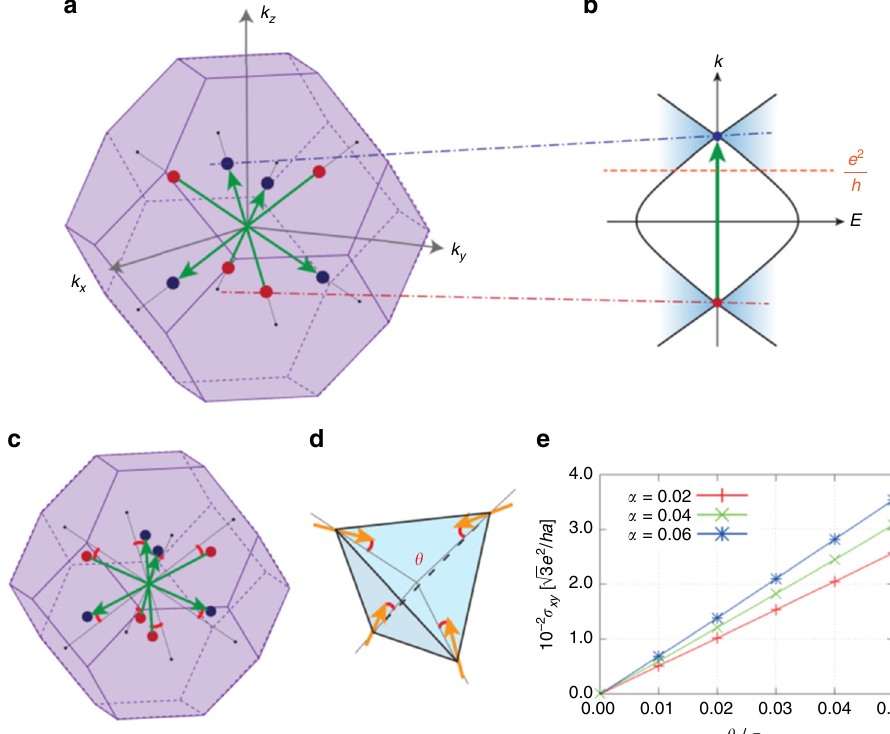
Fig. 4 Theoretical description of Hall effect. a Schematic picture of the Brillouin zone and the Weyl points in the AIAO phase. The green arrows show the vector connecting the two Weyl points related by the spatial-inversion symmetry. The schematic fi gure of the band structure of the Weyl points is shown in b along the crystal momentum k along (111) direction. c The position of the Weyl points in the canted AIAO phase. The canted spin con fi guration is ffiffiffi p e 2 = ha ( a being the lattice constant) as a function of the canting angle θ is in shown in d , and the Hall conductivity in the unit of 3